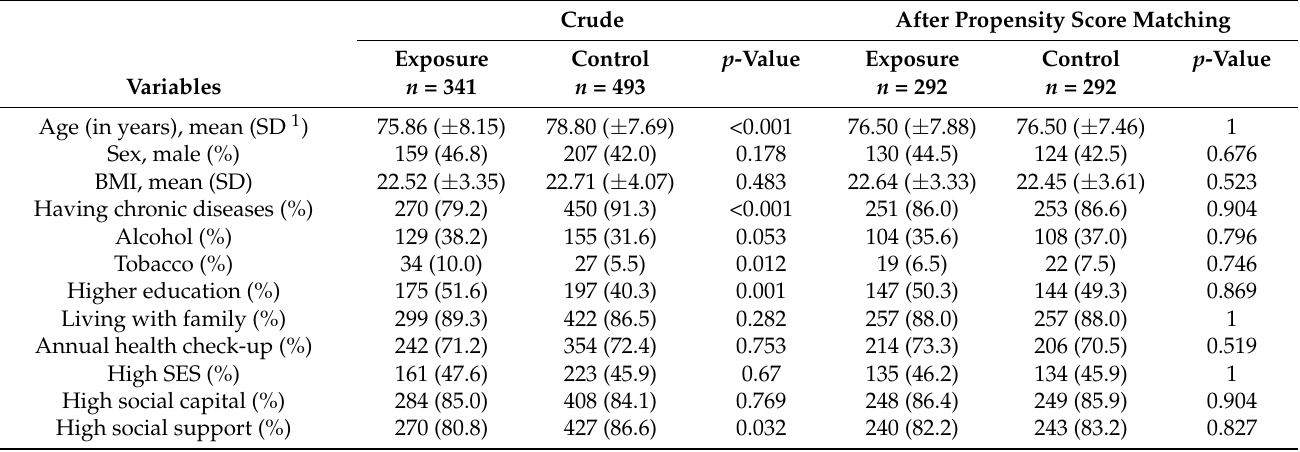
Table 1. Demographic characteristics for each group and significance level of the comparison between the two groups before and after propensity score matching.